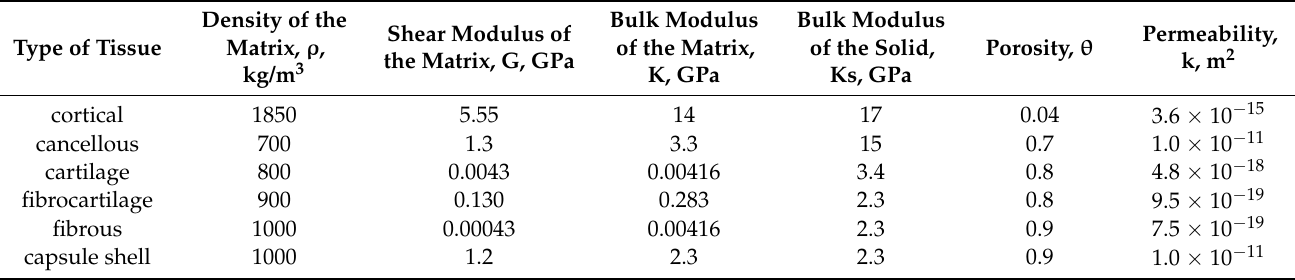
Table 1. Elastic and poroelastic parameters of the bone tissues.